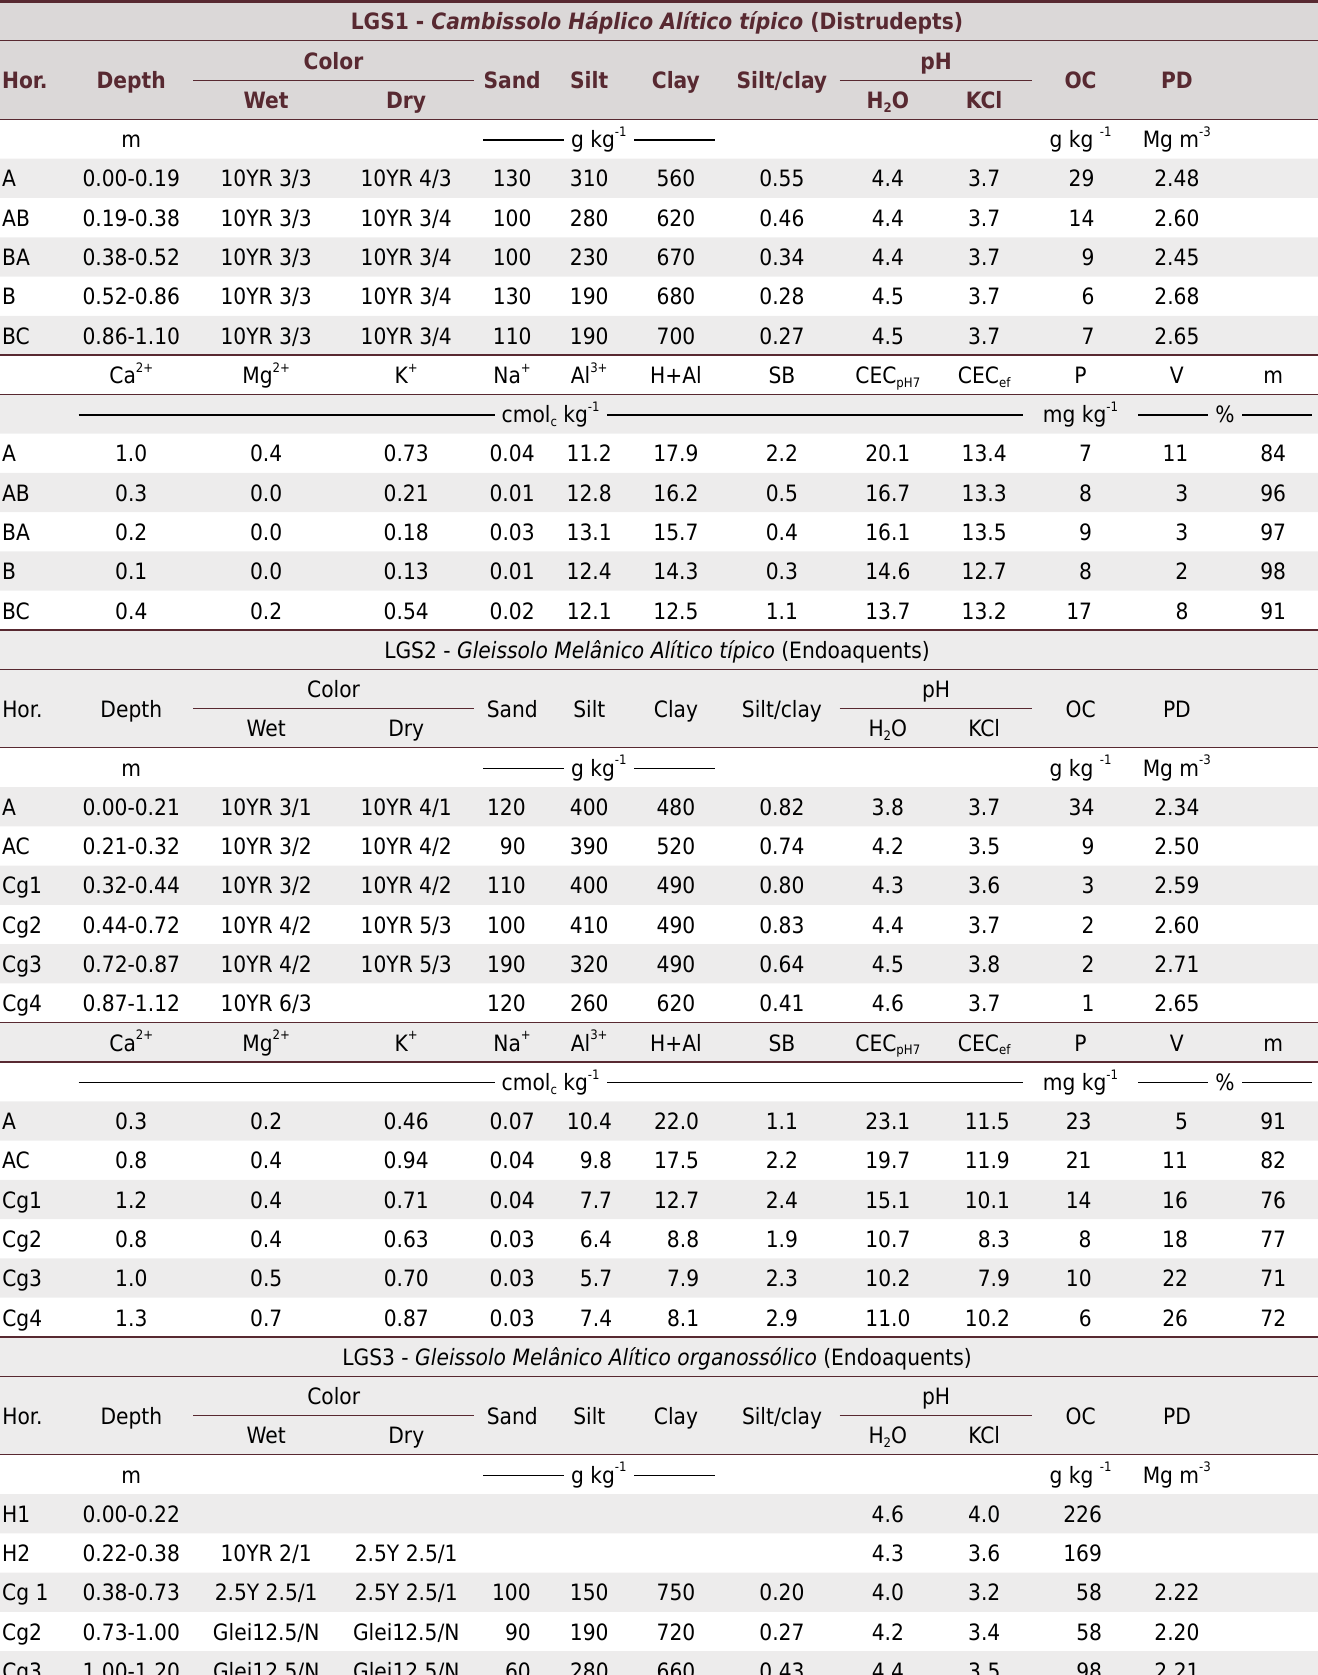
Table 4. Morphological, physical, and chemical properties of the soils collected in the wetland of Lages (LGS), SC, Brazil LGS1 - Cambissolo Háplico Alítico típico (Distrudepts)